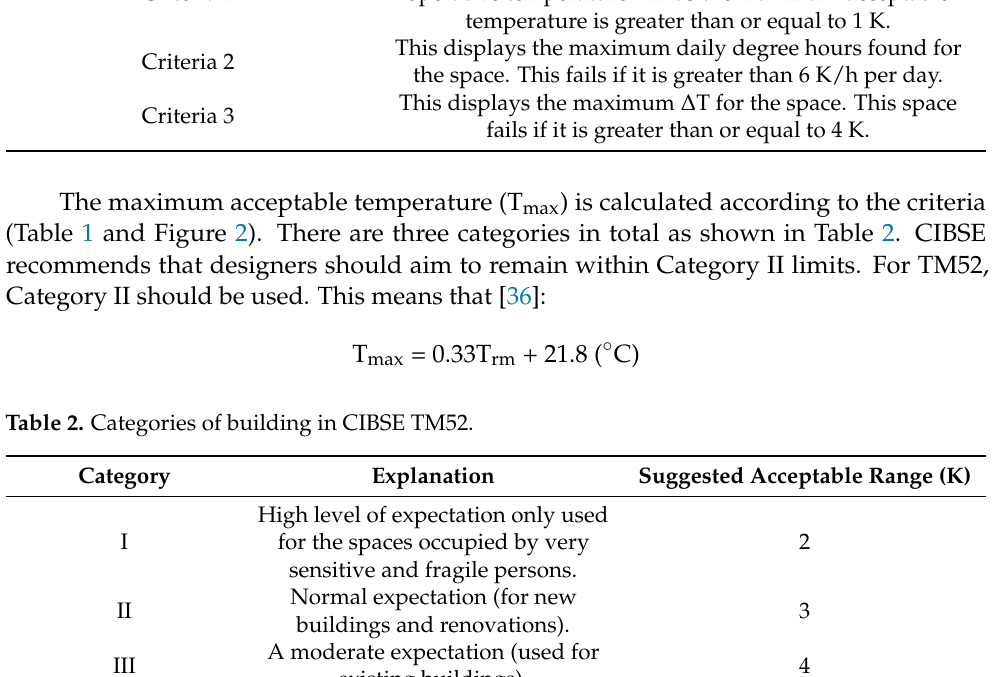
Table 1. Three criteria for overheating from CIBSE TM52. Criteria Content This displays the percentage hours when the difference in Criteria 1 operative temperature minus the maximum acceptable temperature is greater than or equal to 1 K. Criteria 2 Criteria 3